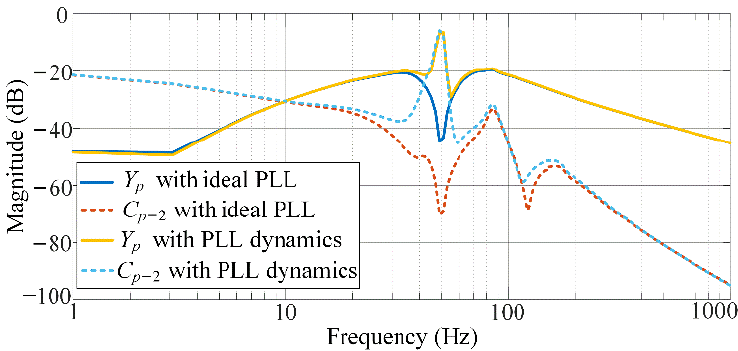
Figure 16. Bode diagrams of the MMC admittances with ideal PLL and PLL dynamics. Substituting the MMC admittance model considering PLL dynamics into the iterative procedure in Figure 10, the conditions for considering the frequency coupling can be obtained. The results show that when SCR < 2.2, the stability assessments are unstable regardless of whether the coupling is ignored or considered. In addition, when SCR > 2.8, the system is always stable regardless of whether the coupling is ignored or considered. analysis will be obtained. Figure 17 shows the characteristic loci of Z g ( s ) Y MMC ( s ) with PLL dynamics. The grid condition of 2.2 < SCR < 2.8 is the condition that ignoring the coupling will result in a wrong stability